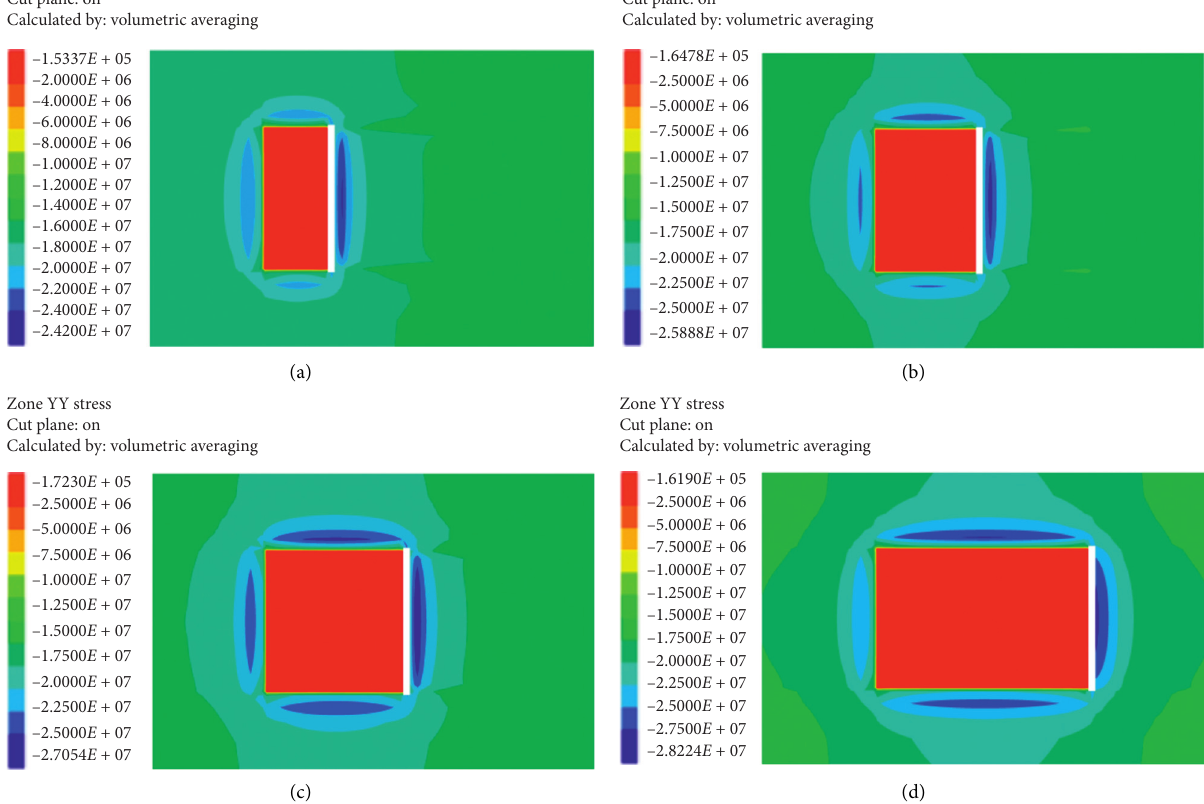
Figure 2: Abutment pressure distribution during face mining at different distances. (a) Advanced 100m. (b) Advanced 150 m. (c) Advanced 200m. (d) Advanced